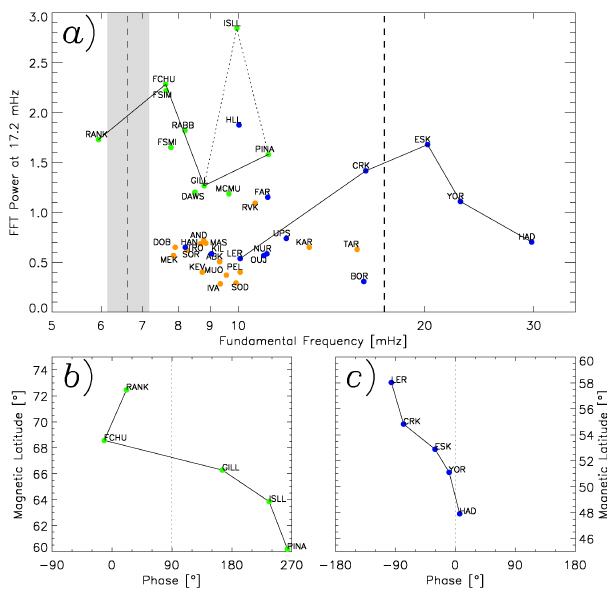
Fig. 11. (a) Fundamental frequency against the spectral power at 17.2mHz. CARISMA stations are coloured green, SAMNET sta- tions are blue and IMAGE stations are orange. (b) Latitude profile of the FFT phase of selected CARISMA stations; these are con- nected by straight lines in panel (a). (c) Latitude profile of the FFT phase of selected SAMNET stations; these are connected by straight lines in panel